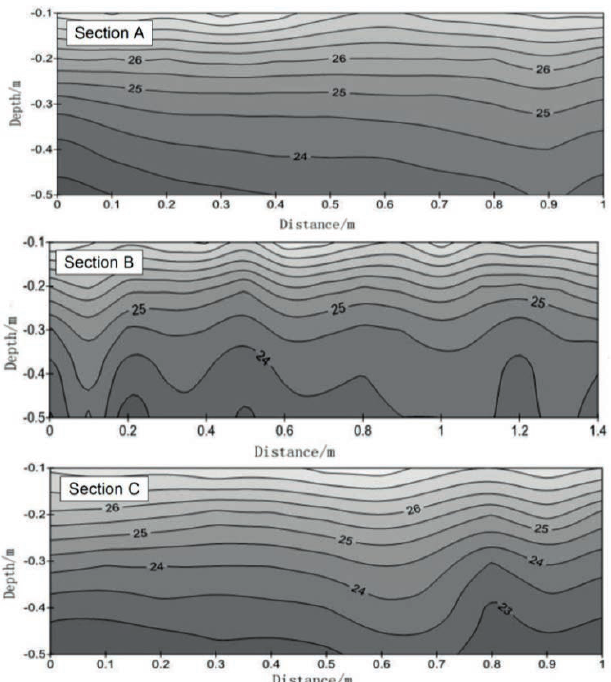
Fig. 3 Temperature profiles ( ° C) for the sections A, B and